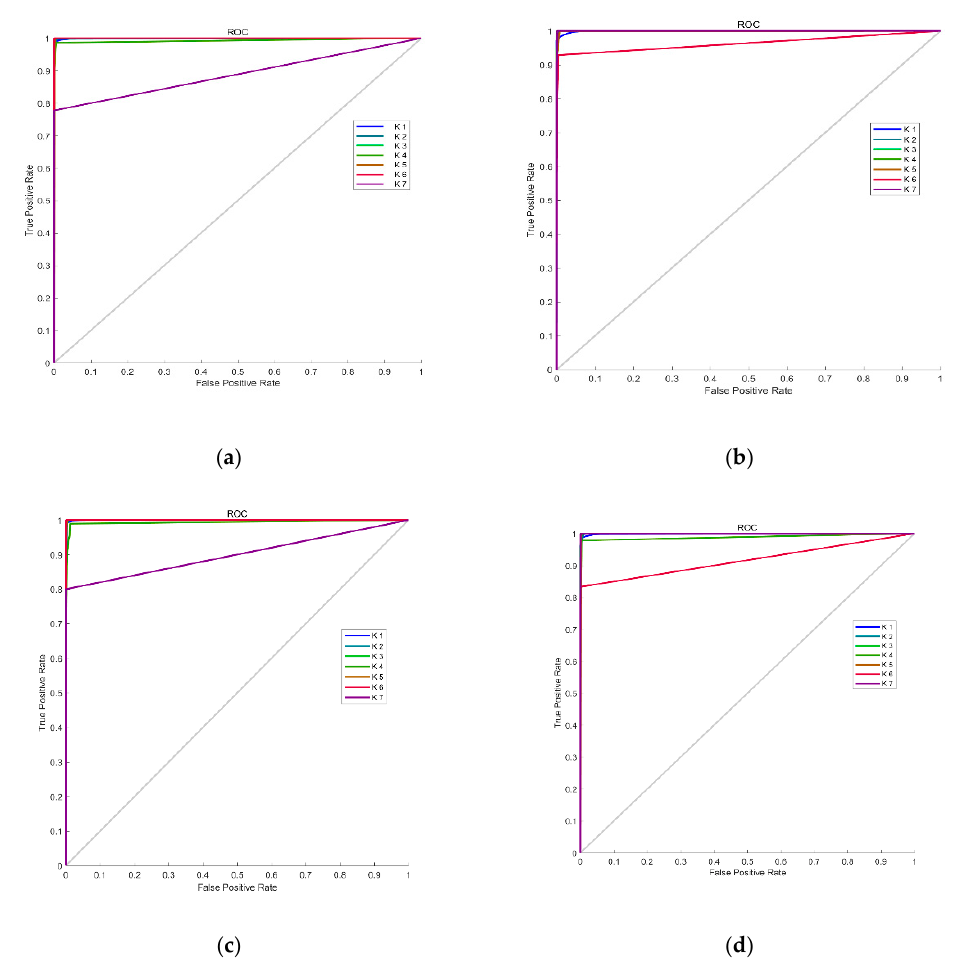
Figure 7. The receiver operator characteristic (ROC) of different testing datasets: ( a ) dataset of Day 1; ( b ) dataset of Day 2; ( c ) dataset of Day 3; ( d ) dataset of Day 4.